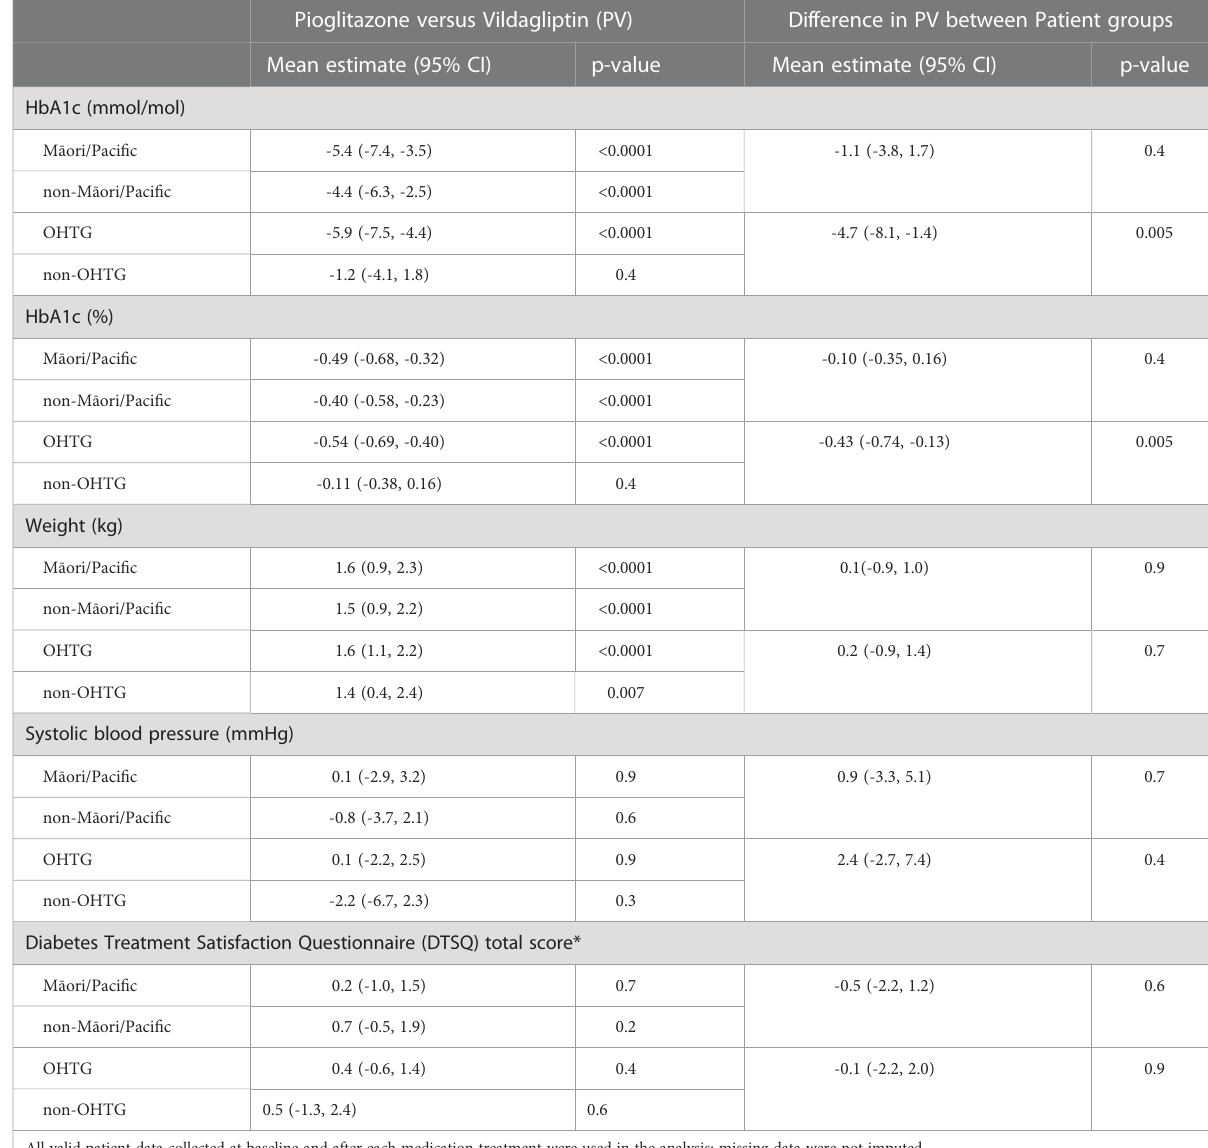
TABLE 4 The estimated medication effects on patient outcomes and its interaction with patient